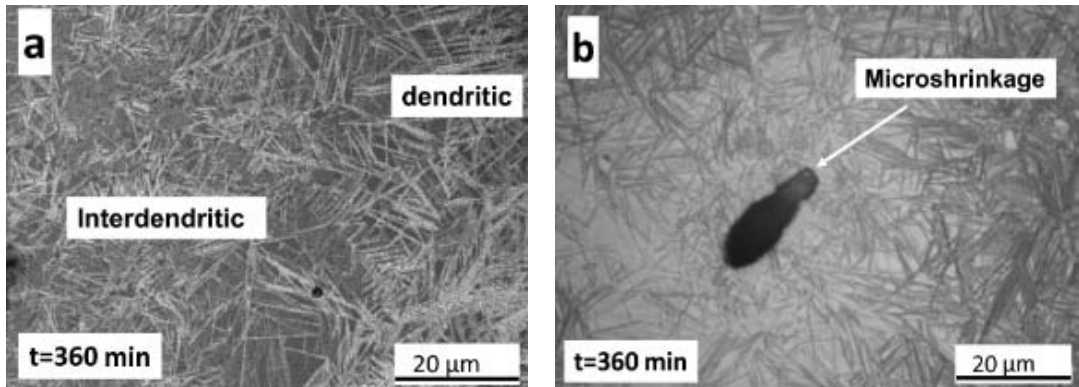
Figure 15. ( a ) FEG-SEM and ( b ) LOM micrographs corresponding to a sample austempered at 230 ◦ C for 360 min. Etched with Nital 2% showing bainitic ferrite plates with different lengths.